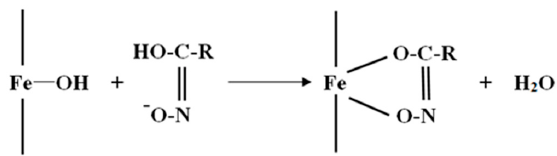
Figure 9. The reaction mechanism of OHA with iron (III) hydroxide on the oxidized pyrrhotite surface.